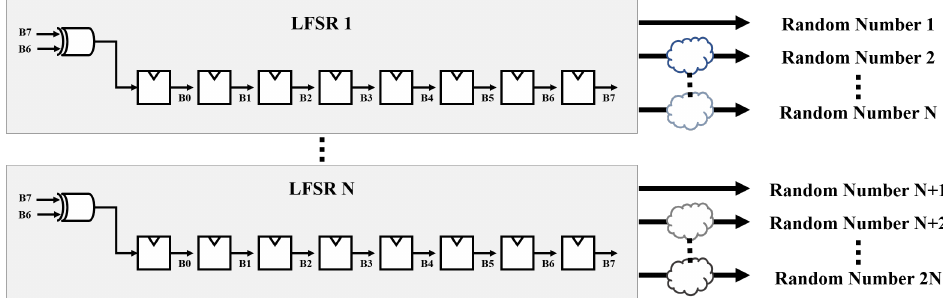
Figure 12. Employing shared LFSRs to obtain multiple random numbers at the same